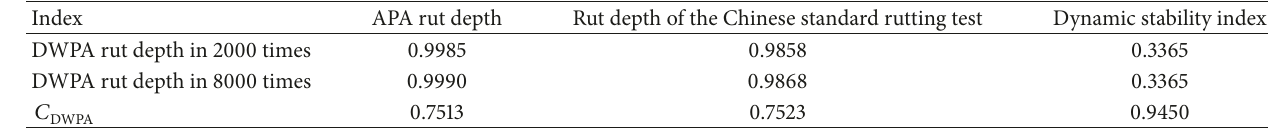
Table 6: Results of grey relational